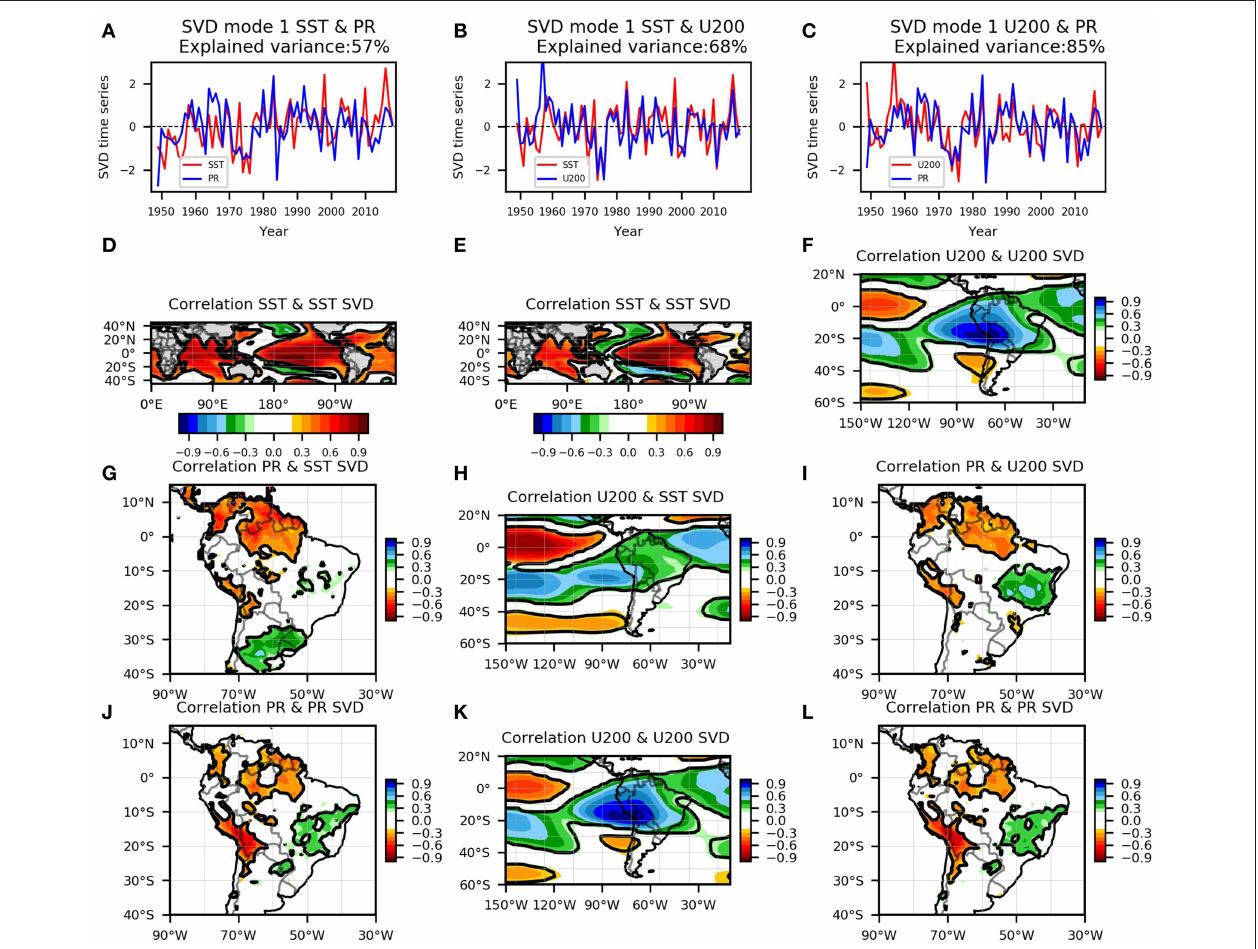
FIGURE 3 | (A) SVD time series of SST (blue) and rainfall anomalies (red) over Altiplano from reanalysis datasets for the period 1949–2018. (D) Homogeneous correlation map between the SVD time series of SST and SST anomalies. (G) Heterogeneous correlation map between the SVD time series of SST and rainfall anomalies. (J) Homogeneous correlation map between the SVD time series of rainfall and rainfall anomalies. (B,E , H,K) same as (A , D , G,J) , but for SVD time series of SST (blue) and U200 anomalies (red) over Altiplano. (C,F,I,L) same as (A,D,G,J) , but for SVD timeseries of U200 (blue) and rainfall anomalies (red) over Altiplano. Contours indicate 95% significance